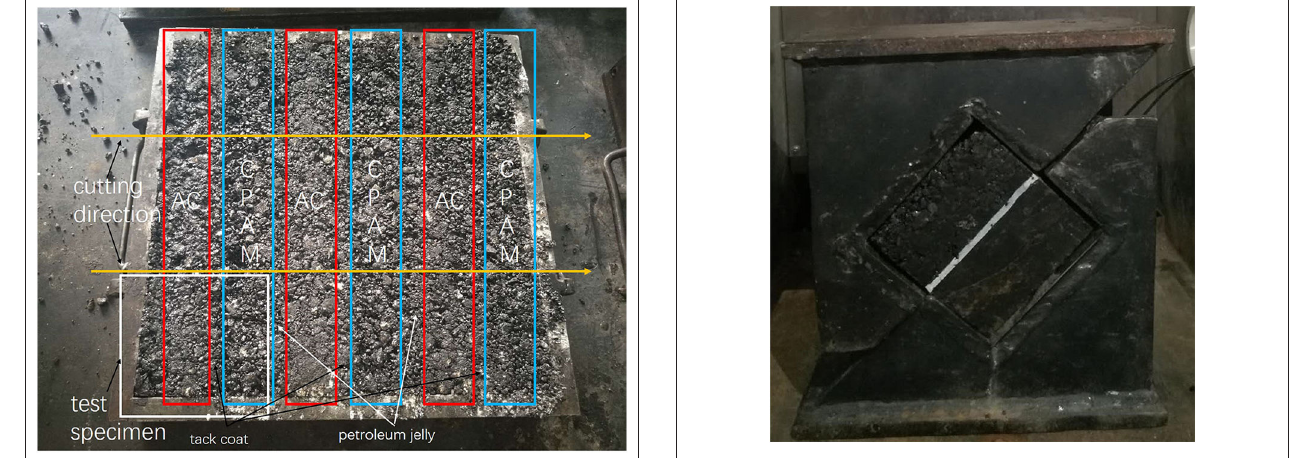
FIGURE 2 | The progress of specimen preparation. FIGURE 3 | The device of oblique shear